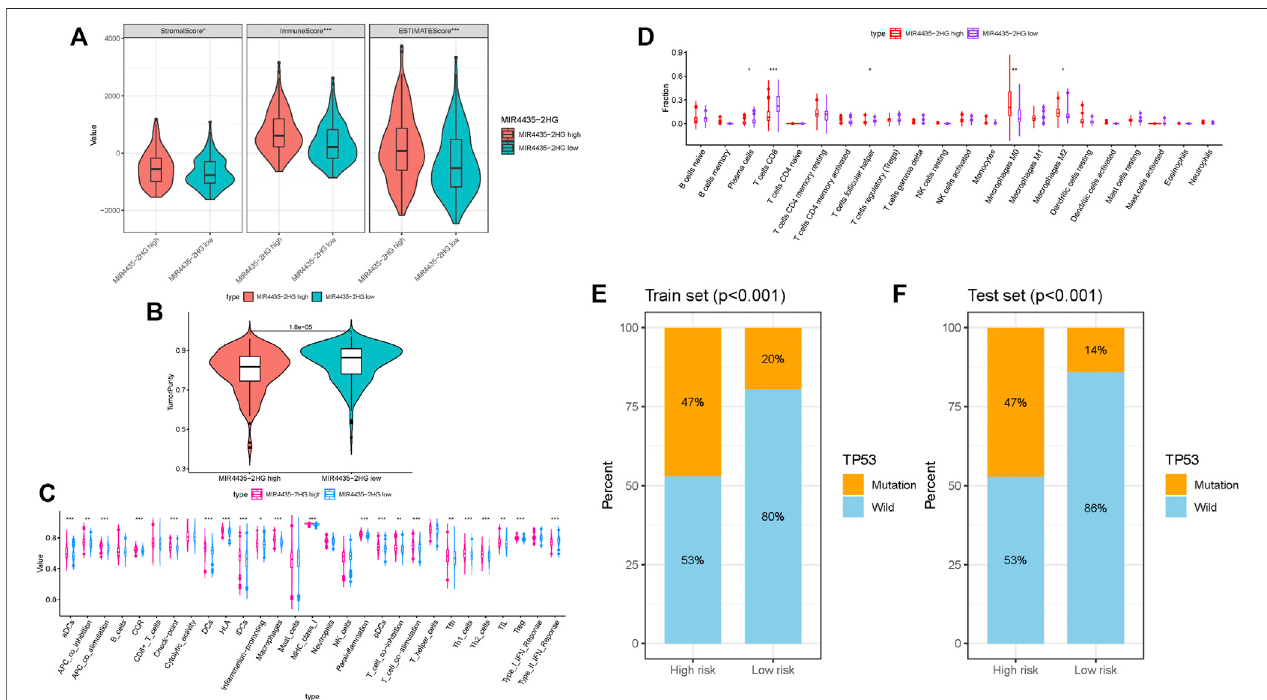
FIGURE 8 | Correlation of MIR4435-2HG in TIME characterization. (A – B) Comparison of the immune score (ESTIMATE algorithm) between MIR4435-2HG low/ high groups. (C) Differenceofimmune-related signaturesbetweenlowandhighMIR4435-2HGsubgroups. (D) Distinctionofin fi ltratingimmunecellsubpopulationsand levelsbetweenlow/highMIR4435-2HGgroups. (E) ProportionofmutationofTP53inbothlow-/high-riskgroupsformthetrainingset. (F) ProportionofmutationofTP53 in both low-/high-risk groups form the testing